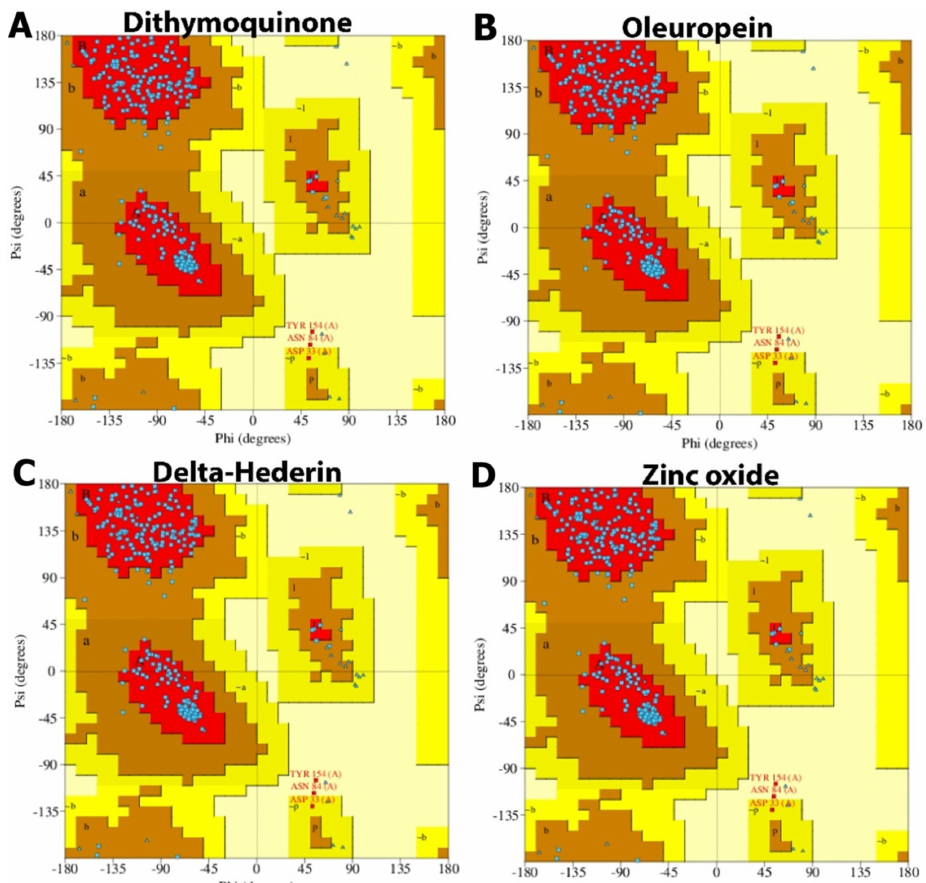
Figure 11. Ramachandran plot of protein interacting with the best docked compounds. ( A ) dithymo- quinone, ( B ) oleuropein, ( C ) δ -hederin, ( D ) zinc